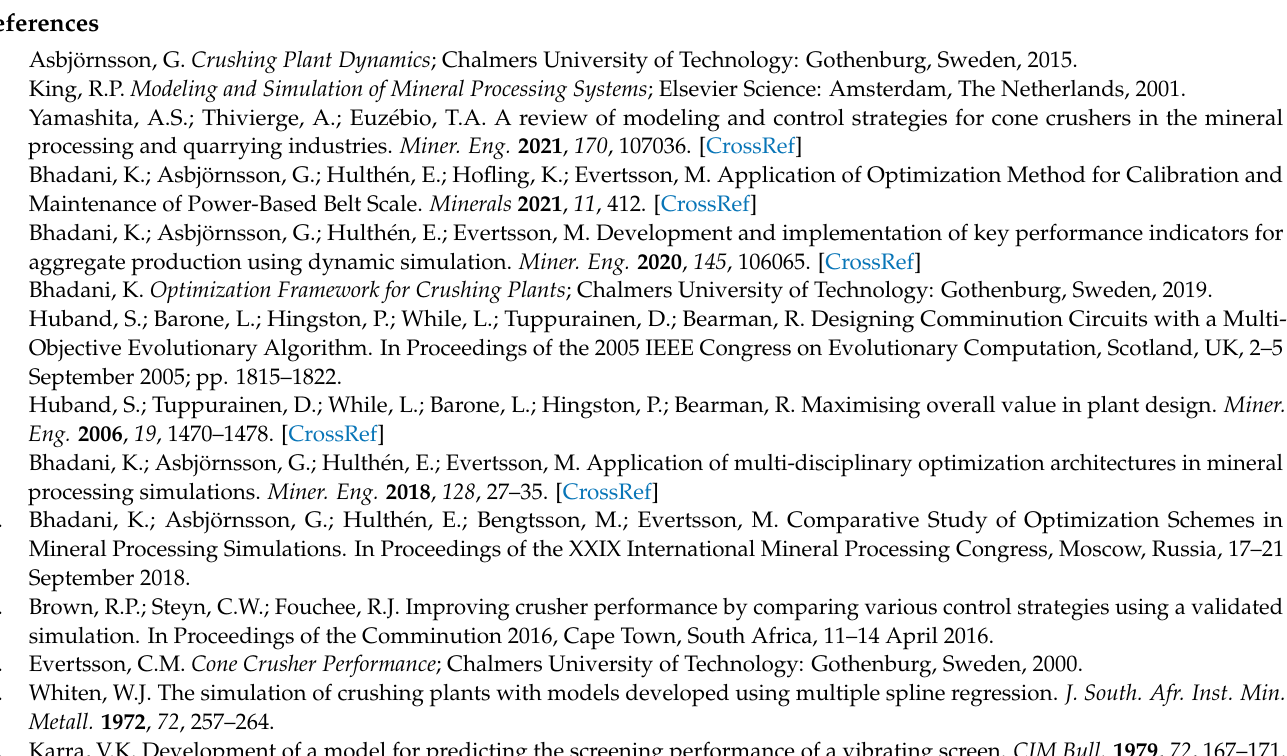
Figure A4. Screen 2 calibration results for T04 in the frequency domain.